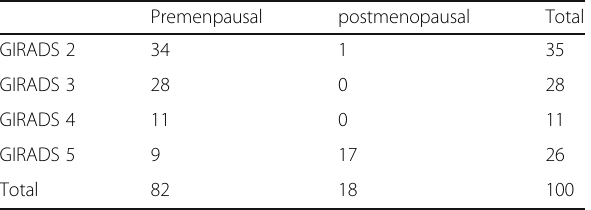
Table 2 GIRADS classification and patient ’ s age whether pre